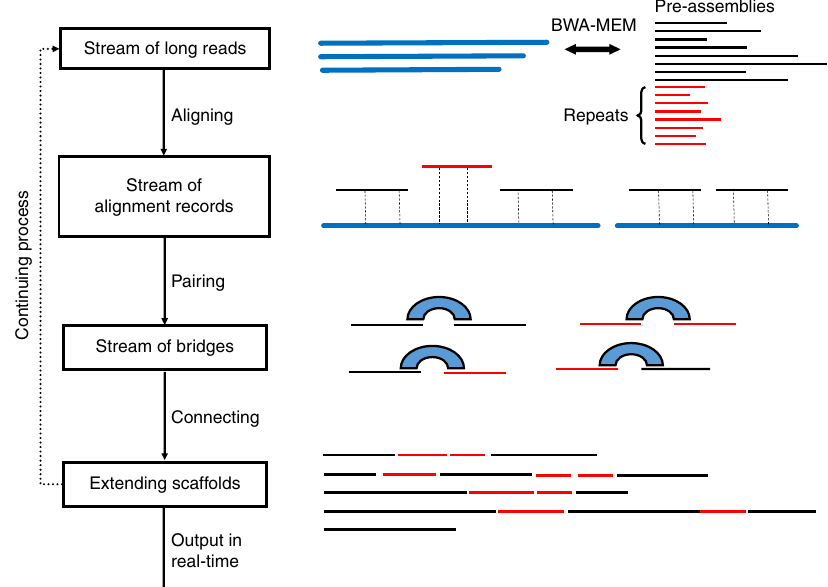
Figure 1 | Workflow of the real-time algorithm. Stream of long reads are aligned to the existing contigs to create alignment records. Bridges connecting contigs are formed, and are used for extending scaffolds. These steps are performed in a streaming fashion.